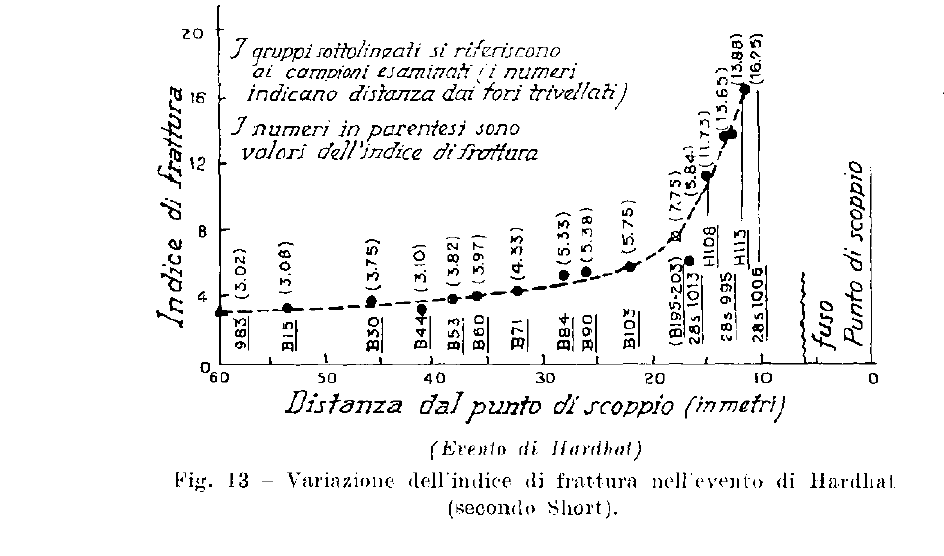
Fig. 13 - Variazione dell'indice di frattura nell'evento di Hardliat (secondo